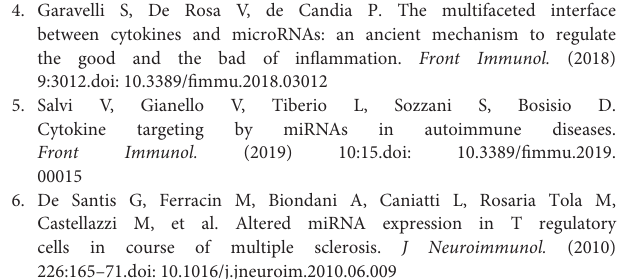
Figure S1 | One representative image of the whole section of spinal cord presented in Figure 3 . Spinal cord sections were stained with Hematoxylin and Eosin, Kluver Barrera, and Bielschowsky to asses number of infiltrates, demyelination, and axonal loss. Figure S2 | mRNA levels of classical targets for miR17-92 and miR106b. mRNA levels of p21, BIM, and STAT3 were measured in the brain, spinal cord, lymph nodes and spleen by real time RT-PCR. Data are shown as arbitrary units (AU). ∗ P < 0.05 (Mann Whitney